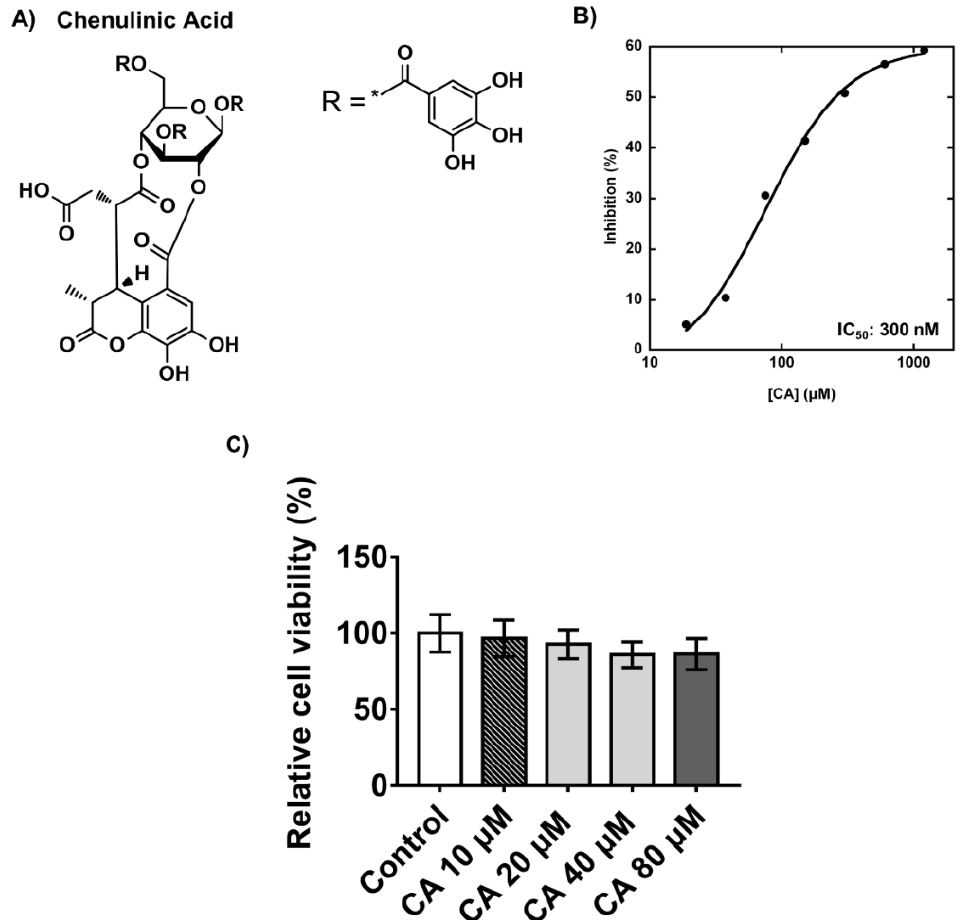
Figure 3. Inhibitory effect of chebulinic acid on PPP1CB. ( A ) Chemical structure of chebulinic acid (CA); ( B ) the half-maximal inhibitory concentration (IC 50 ) of chebulinic acid against PPP1CB catalytic activity. Chebulinic acid was diluted from 12 to 0.019 µ M in dimethyl sulfoxide (DMSO). Next, 10 µ L of diluted chebulinic acid was added to 80 µ L of reaction buffer containing 304 µ M DiFMUP. Next, 10 µ L PPP1CB (1.5 nM of final concentration) was added to the reaction buffer containing DiFMUP and chebulinic acid. IC 50 value was calculated using the sigmoid dose–response model with the seven data points; ( C ) cytotoxicity of chebulinic acid on 3T3-L1 preadipocytes. Cell viabilities were measured using the water-soluble tetrazolium (WST)-1 assay. Results are presented as the mean ± standard deviation.